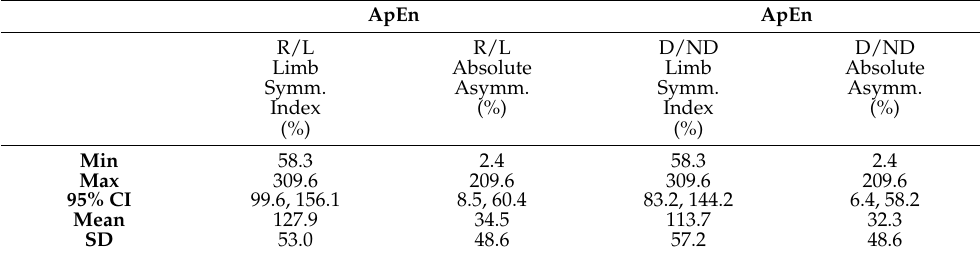
Table 5. Summary statistics for approximate entropy symmetry indices and absolute asymmetries (n = 16).